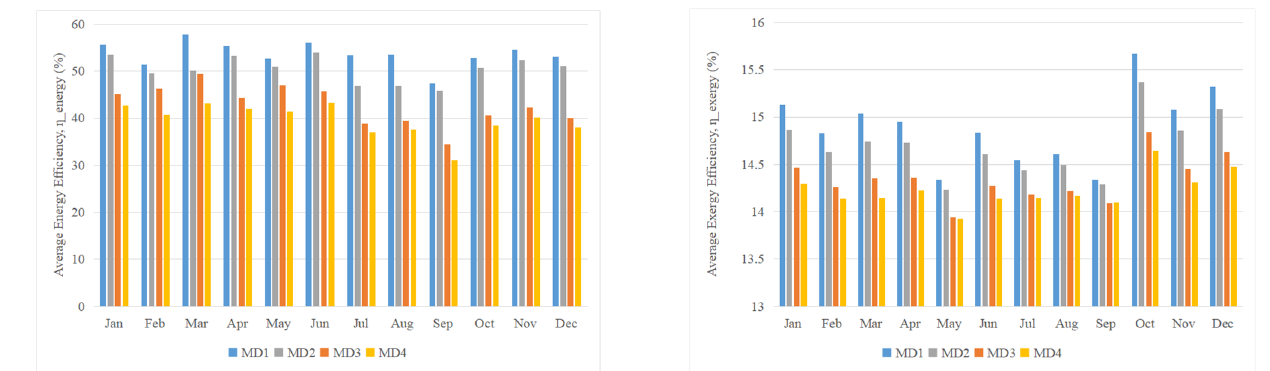
Figure 13. The average energy and exergy efficiency of AWHS over the months.